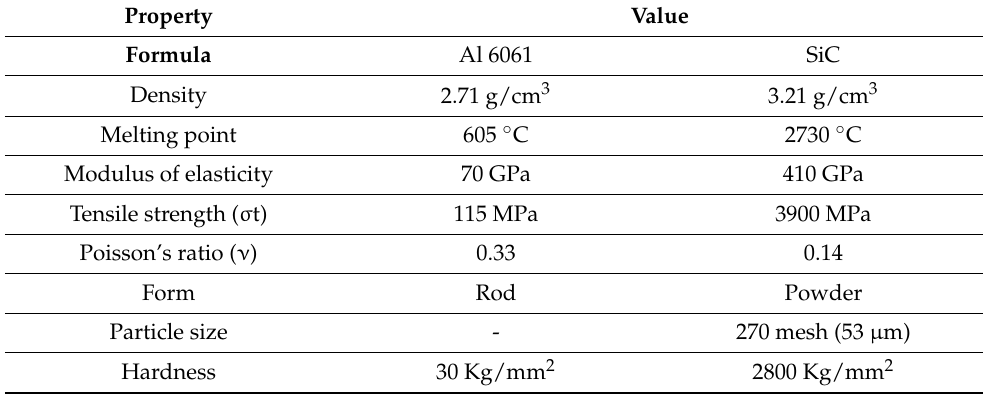
Table 2. Properties of Al 6061 and silicon carbide (SiC).